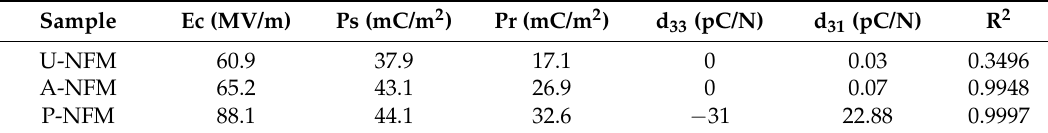
Figure 4. Experimental and theoretical studies of piezoelectric coefficient d31 of nanofiber membranes. ( a ) Experimental charge density–stress curve of U-NFM. Experimental (symbols) and linear fitting (lines) charge density–stress curves of ( b ) A-NFM and ( c ) P-NFM. Table 1. Electric properties of P(VDF-TrFE) NFMs with different postprocessing steps at an electric field of 160 MV/m.